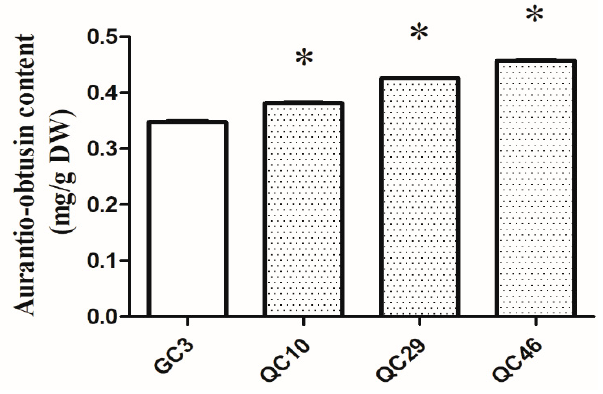
Figure 2. The aurantio-obtusin content of SP-lines and GC3. Note: Asterisks indicates significant differences between SP-lines and GC. (* p < 0.05, Student’s t -test). The values are representative of three biological replicates.